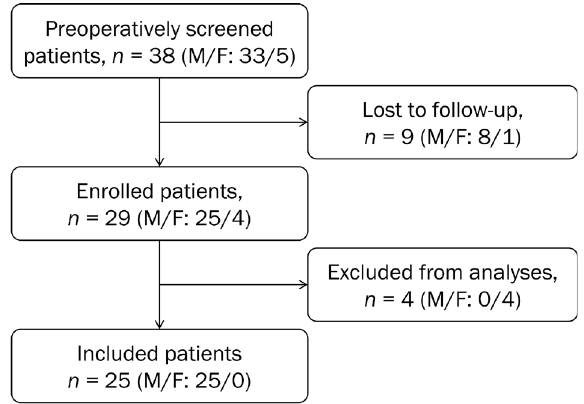
Figure 1. Flow chart of the study population.